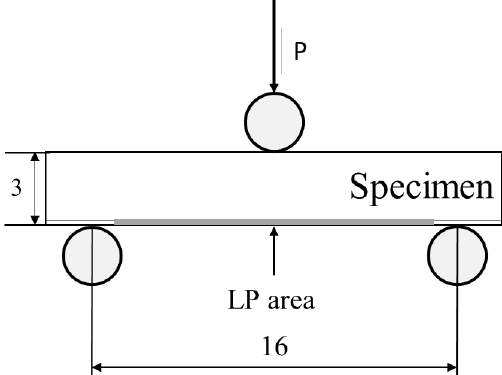
Figure 4. Schematic diagram of three-point bending test. (unit: mm).